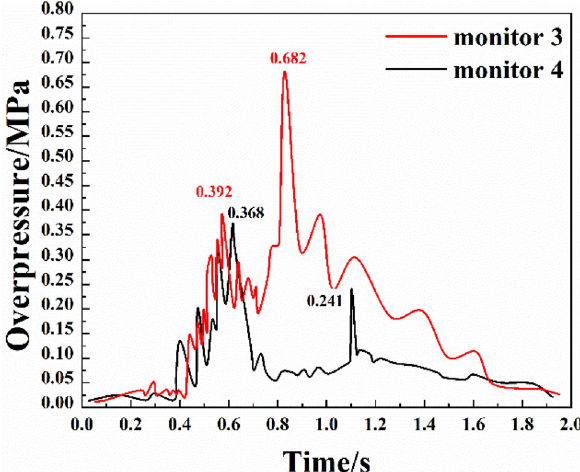
Figure 5. Overpressure change of bifurcation 2.